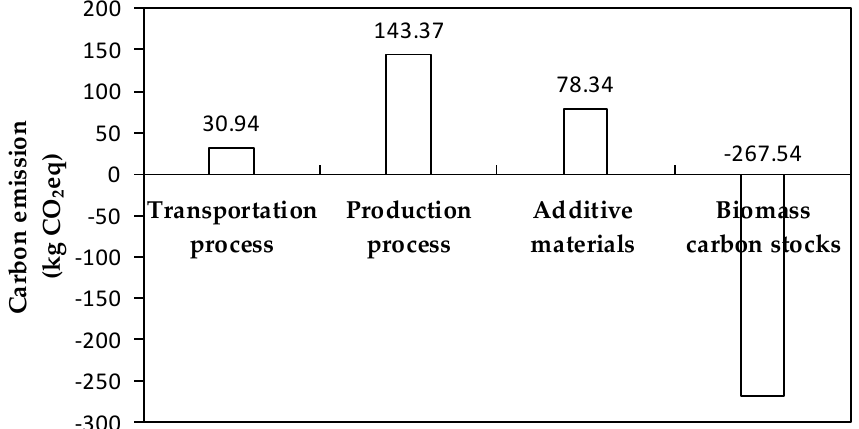
Figure 2. The composition of the carbon footprint for producing 1 m 3 bamboo scrimber flooring.